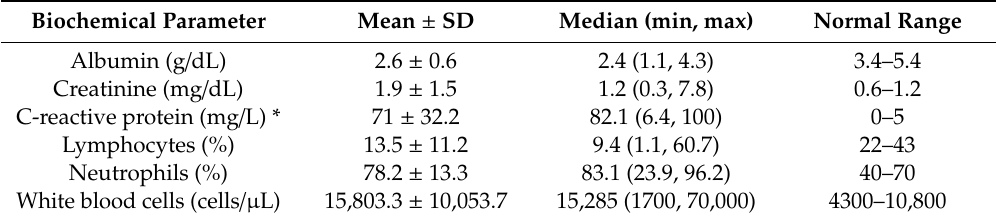
Table 2. Patients’ biochemical parameters.